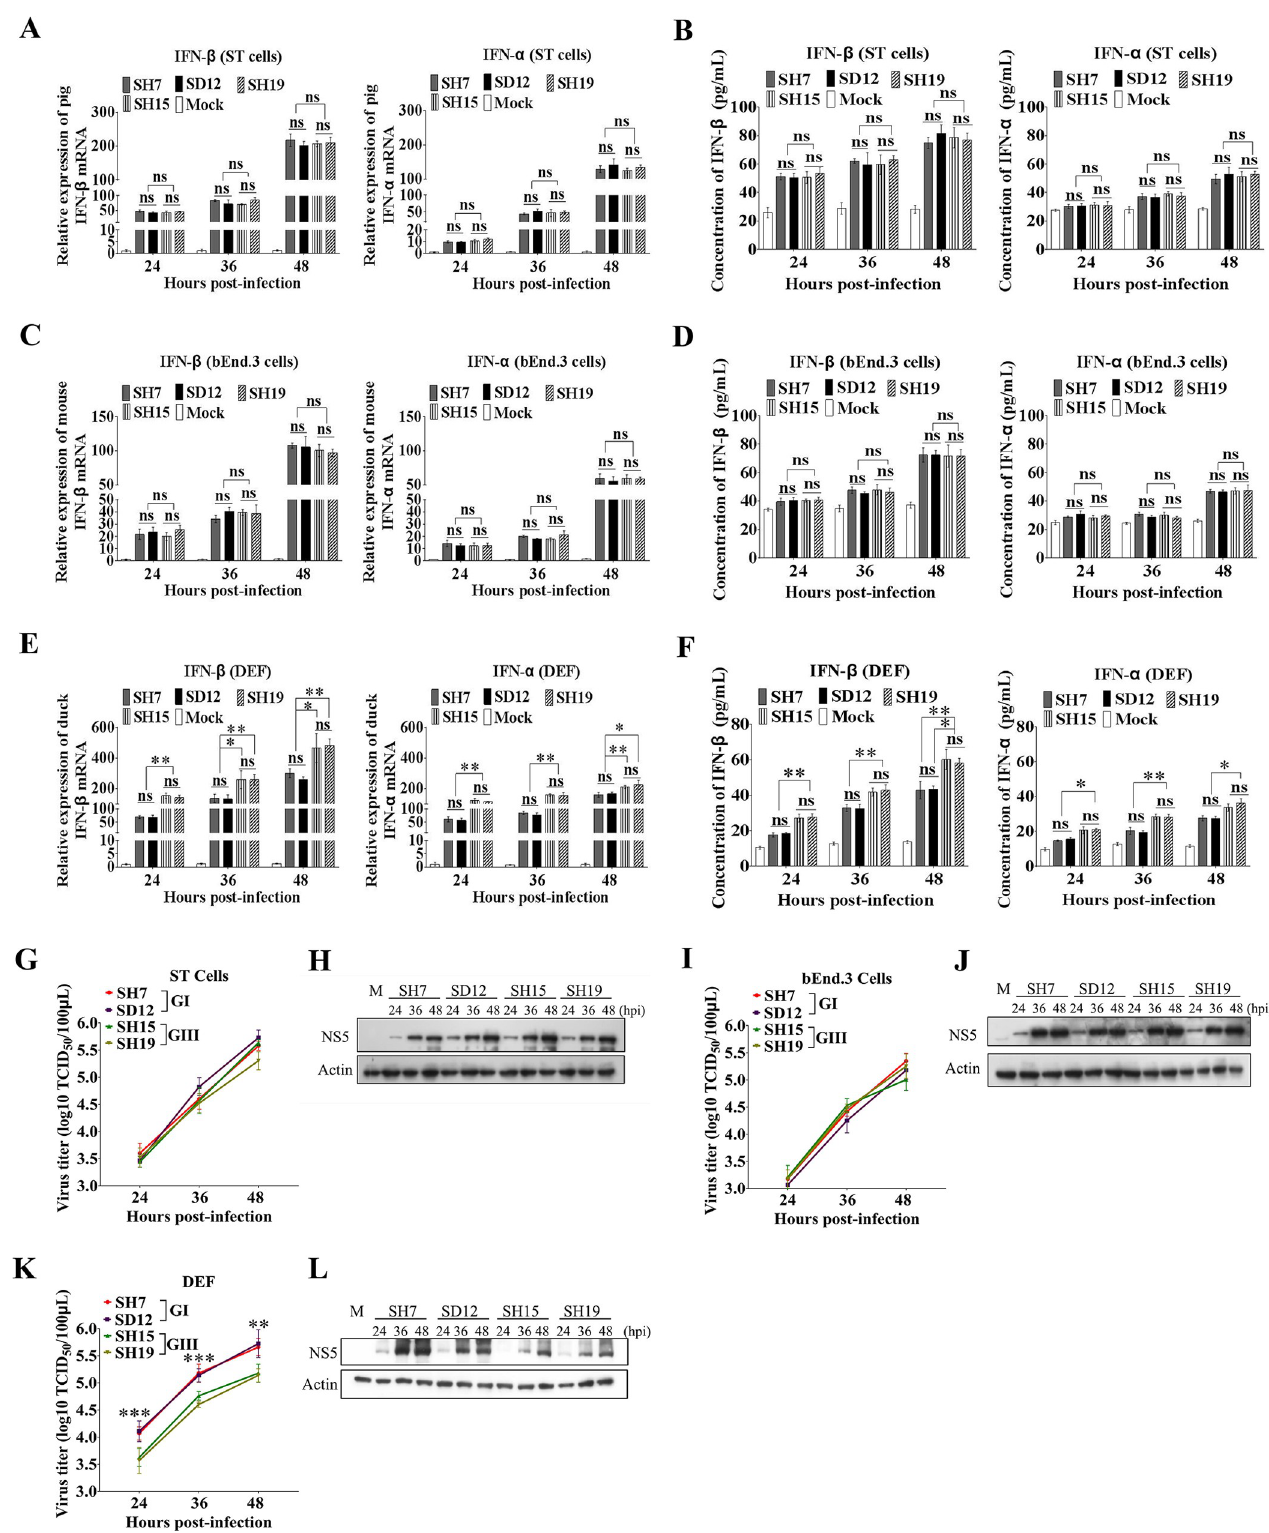
Fig 1. Differences in IFN- α and β induction and replication efficiency between the GI and GIII strains. ST, bEnd.3, and DEF cells were infected with GI (SH7 and SD12) and GIII (SH15 and SH19) strains at 0.1 MOI and harvested at 24, 36, and 48 hpi for measurement of IFN- α and β production and viral